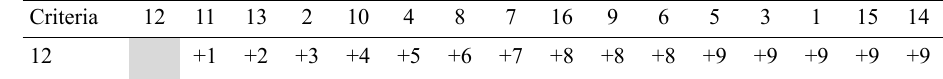
Table 6. The part of the criterion potential impact transferred to the 12 main criterion determined by the experts